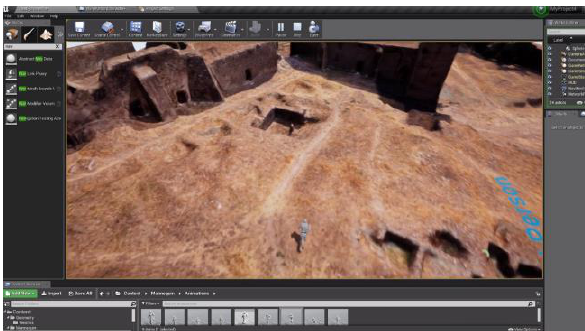
Figure 10. Digital 3D model integrated in Unreal Engine.